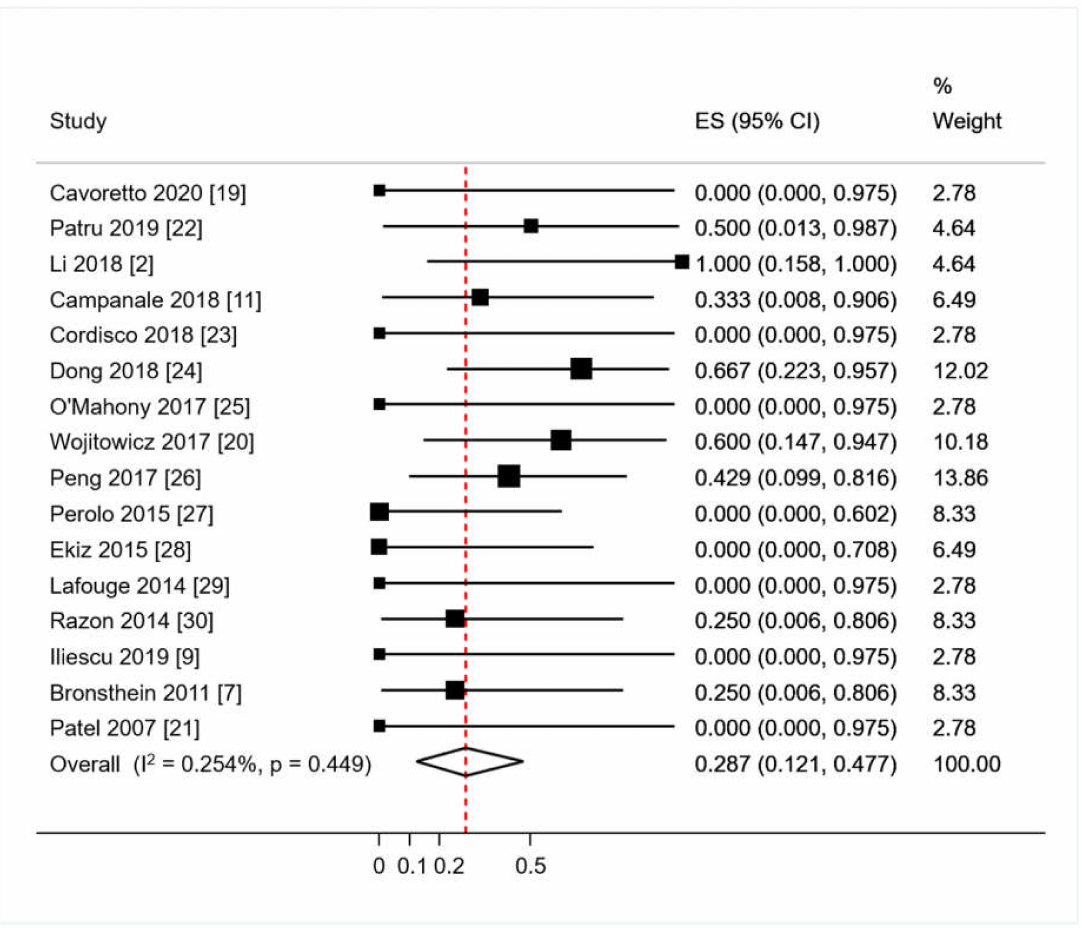
Figure 2. Pooled proportion of intracardiac anomalies in RAA / RDA (right aortic arch with concomitant right ductal arch) fetuses. ES: e ff ect size. CI: confidence interval. Red dashed line describes the e ff ect estimate found in the present